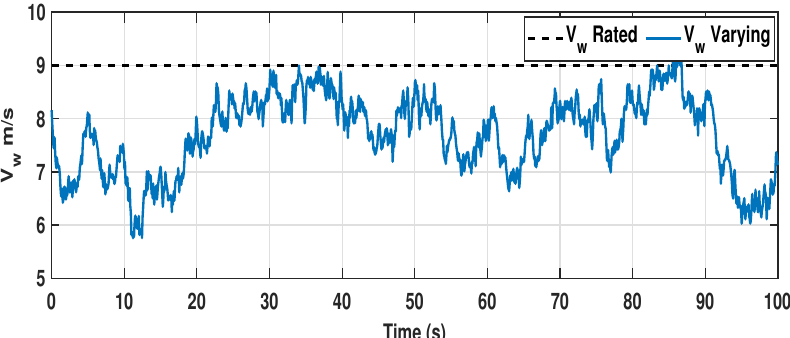
Figure 5. Random wind profile with mean value of 8 m/s for region II